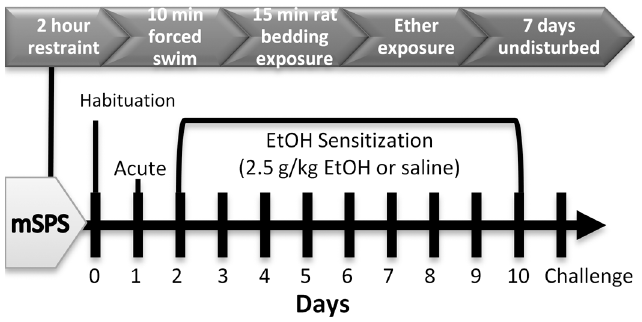
Fig 1. The above timeline of events summarizes the mSPS and EtOH sensitization